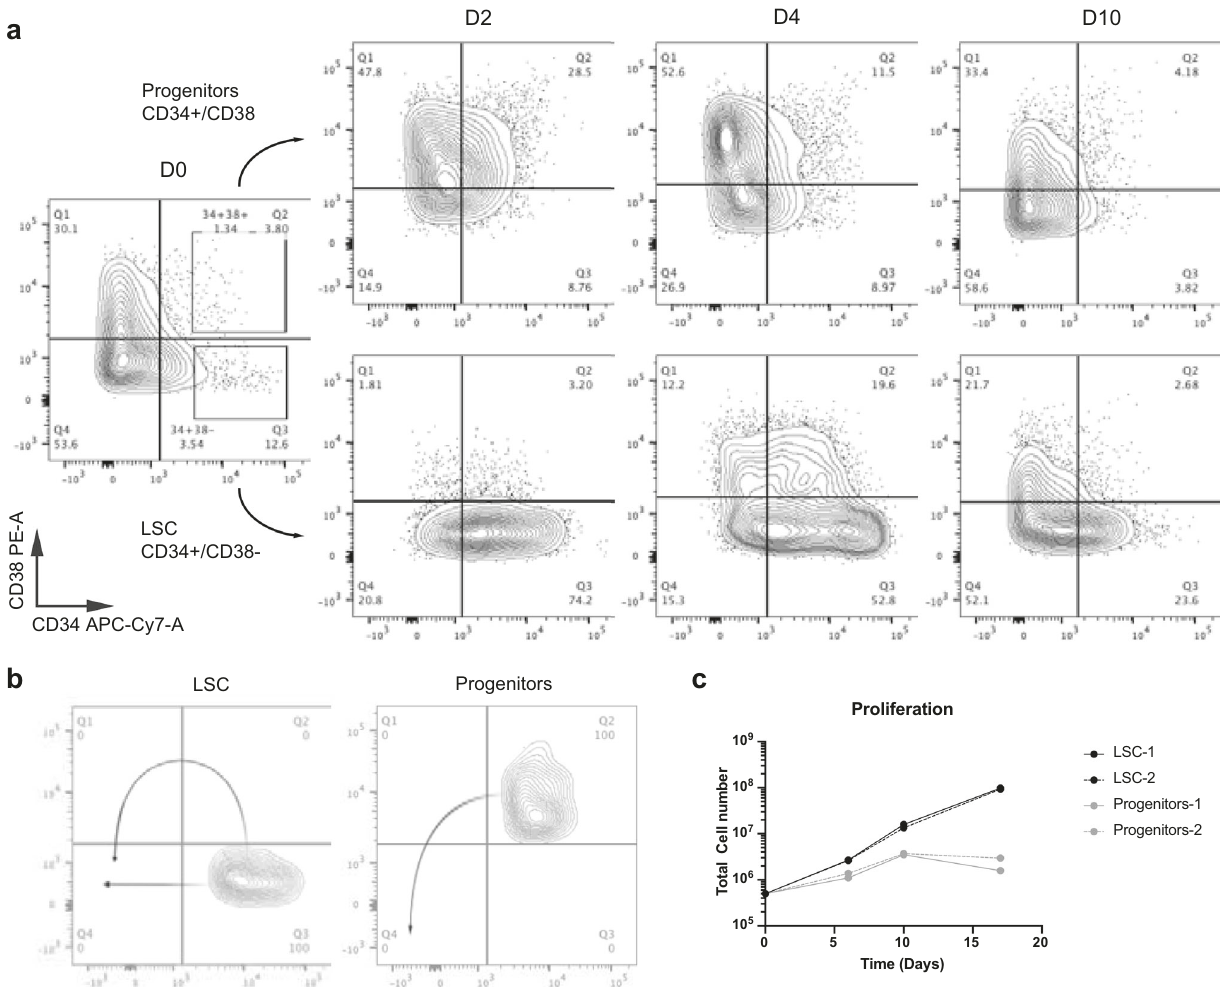
Fig. 6 FACS differentiation assay of OCI-AML8227 culture system. a Leukemia stem cells (LSCs) and progenitors were sorted and their differentiation was assessed over a 10-day period using FACS analysis. b Proposed differentiation of LSCs and progenitors. c Cell proliferation of cultures initiated by LSCs or progenitors as biological duplicates. Source data are provided as a Source Data fi